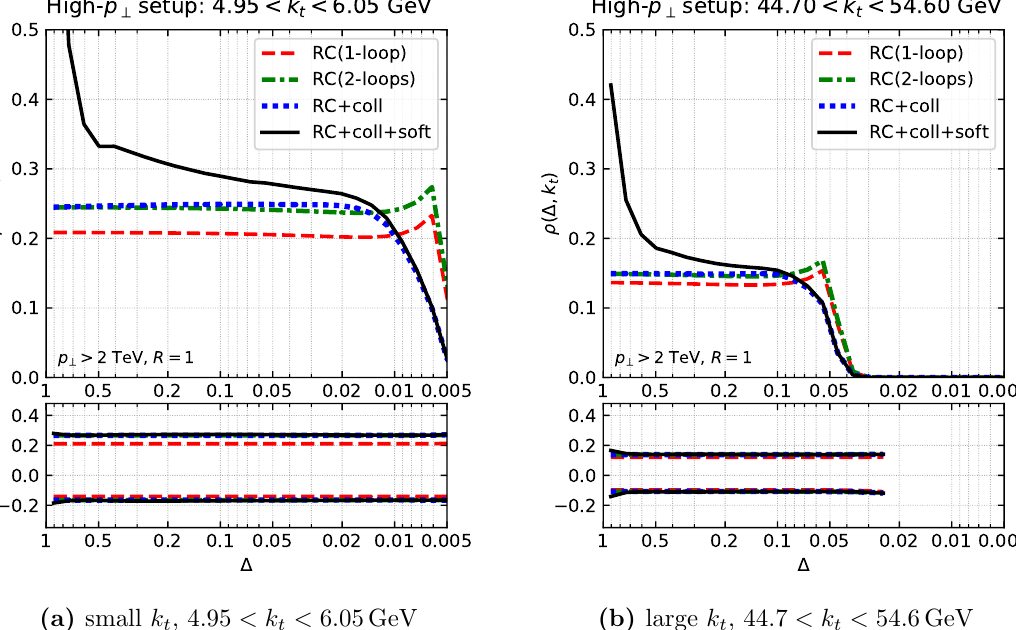
Figure 7. Same as (cid:12)gure 6, now for slices of constant k t